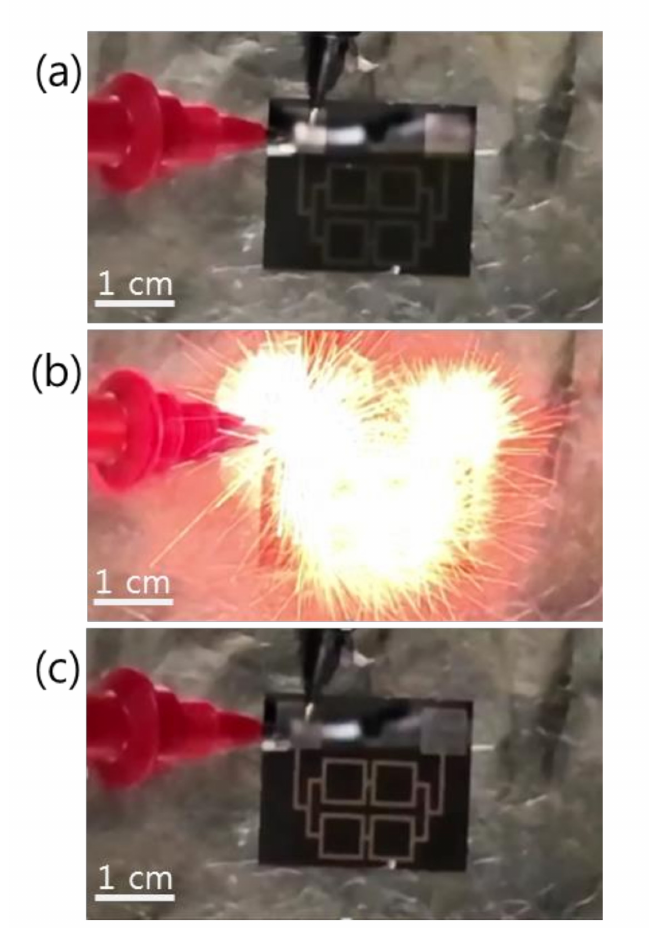
Figure 3. Reaction propagation across a patterned Pd/Al-iRMS of squared frames grown on a Si- wafer. ( a ) Initiation step; ( b ) Maintained propagating reaction step; ( c ) Reaction product morphology after the reaction